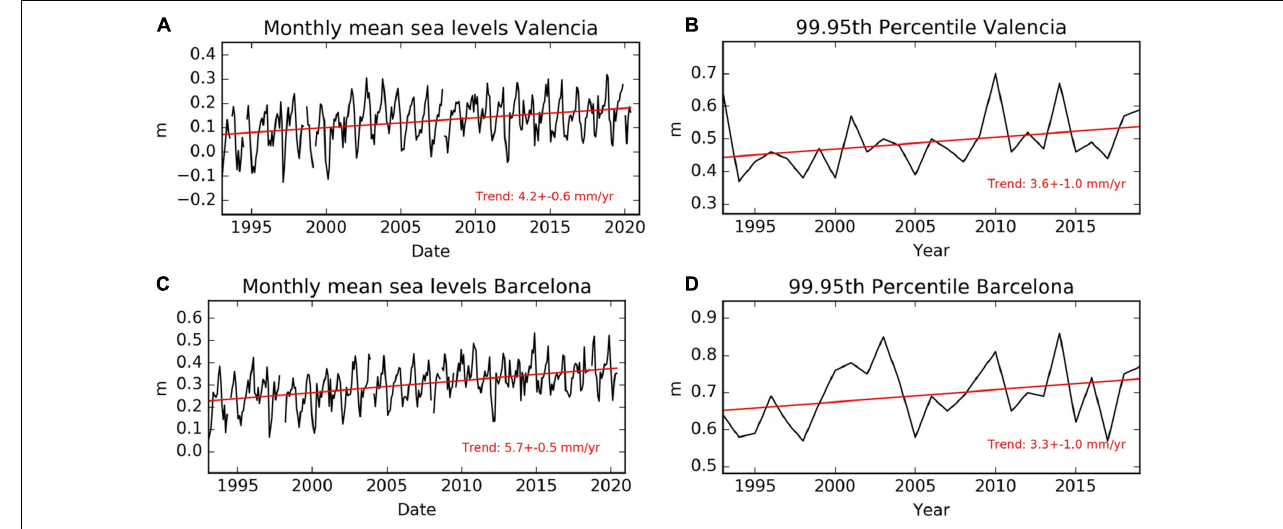
FIGURE 5 | Long term evolution of monthly MSLs and 99.95th annual percentiles at Valencia (A,B) and Barcelona (C,D) . Sea levels are referred to TGD. In red: linear regression fit and trend in